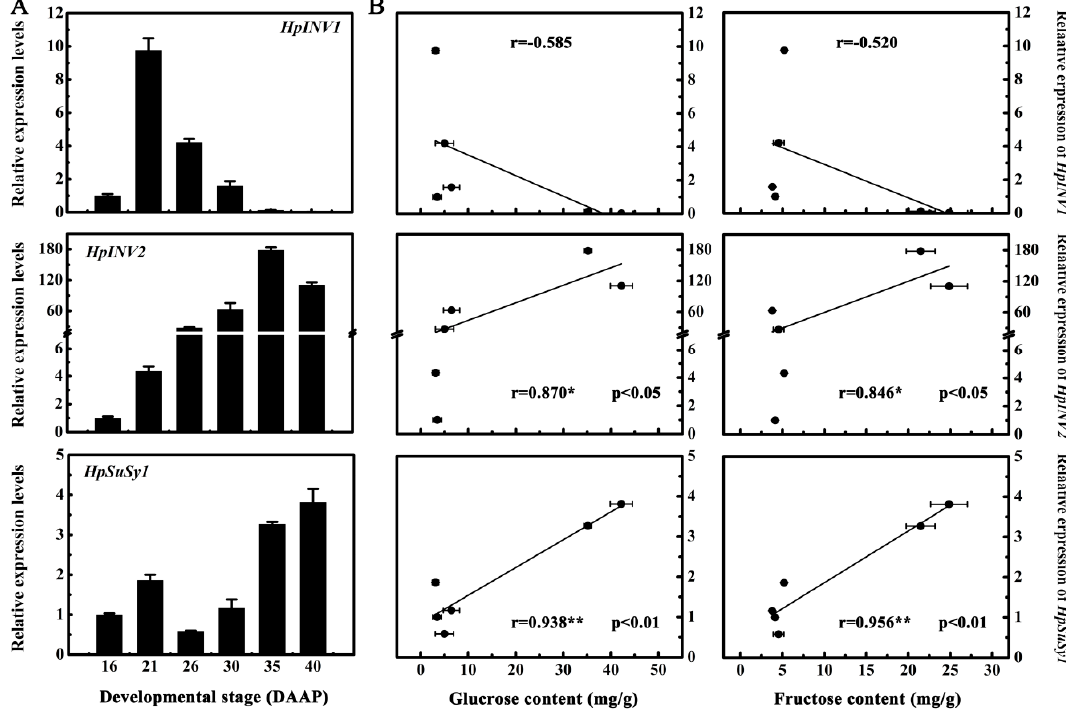
Figure 2. The expression of HpINV2 and HpSuSy1 are correlated with glucose and fructose accumulation during pitaya fruit maturation. ( A ) The expression patterns of sucrose metabolic genes HpINVs and HpSuSy1 in pitaya fruit at different developmental stages. Fruit at 16, 21, 26, 30, 35, and 40 days after artificial pollination (DAAP) was sampled for analysis. Expression values are means ± S.E. of three biological replicates normalized using ACTIN as an internal control. ( B ) Correlation between HpINVs and HpSuSy1 expression levels and contents of glucose and fructose. * and ** represent significant correlation at 0.05 and 0.01 level respectively determined by SPSS Statistics 20.0.